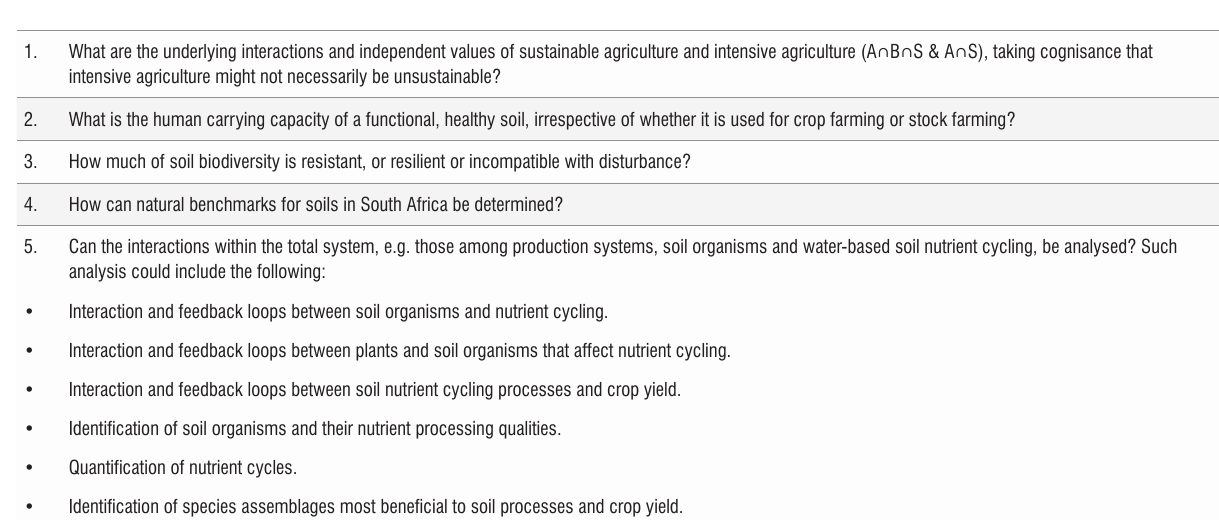
Key research questions/topics in soil ecology in South